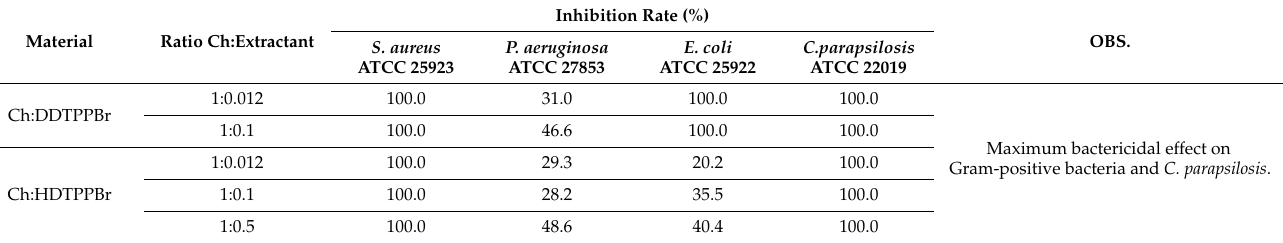
Table 5. Inhibition rate of bacterial and fungal growth when using phosphorus heteroatom